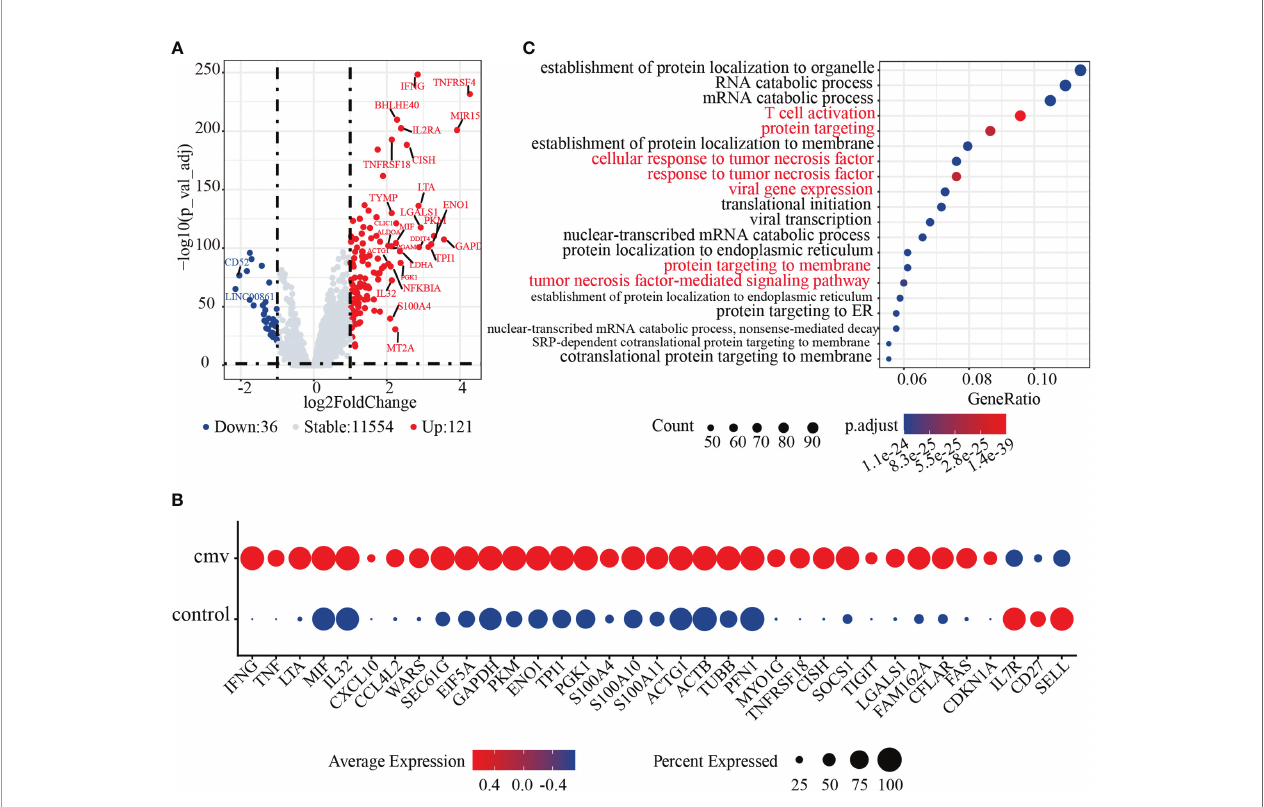
FIGURE 3 | Activation characteristics of CMV pp65 stimulated recently activated CD4+ T (CD4+ Tra) cells. (A) Volcano plot showing the relationships between -log10(adjusted p value) (y-axis) and log2(fold change) (x-axis) for genes differentially expressed by CMV CD4+ Tra and control naive CD4+ T cells. Genes with log2 fold changes > 1 and adjusted p values < 0.05 were upregulated in CMV CD4+ Tra cells and highlighted in red, whereas genes with log2 fold changes < -1 and adjusted p values < 0.05 were downregulated in CMV CD4+ Tra cells and highlighted in blue. (B) GO analysis of DEGs by CMV CD4+ Tra cells and control naïve CD4+ T cells. The Top 20 enriched GO terms are ordered on the y-axis. The x-axis indicates gene percentages in enriched GO terms. The sizes of the dots represent the number of genes included in each GO term. The color gradient of dots represents the adjusted p-values for each enriched GO term. (C) Dot plot of highly featured genes expressed by CMV CD4+ Tra cells and control naïve CD4+ T